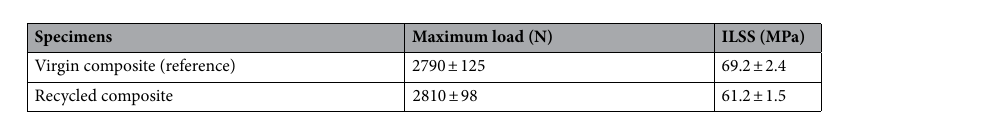
Table 1. Maximum load and ILSS values of reference and recycled composite